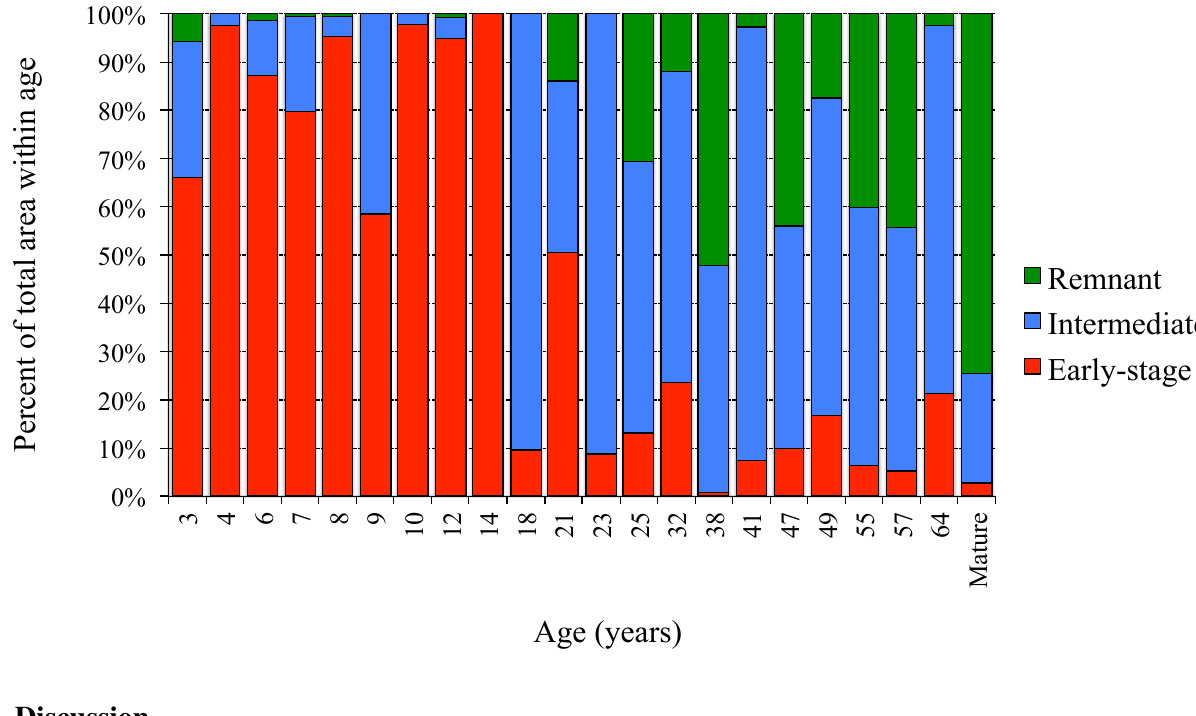
The proportion of early and intermediate regrowth and remnant stages, as generated from the significance-based classification (using z -scores) within different age classes, expressed as percentage of the total area within the age class. The majority of forests less than 15 years were classified as early-stage regrowth whilst the mature forests were classified as remnant. Forests aged at between 18 and 64 years contained a mixture of intermediate and remnant